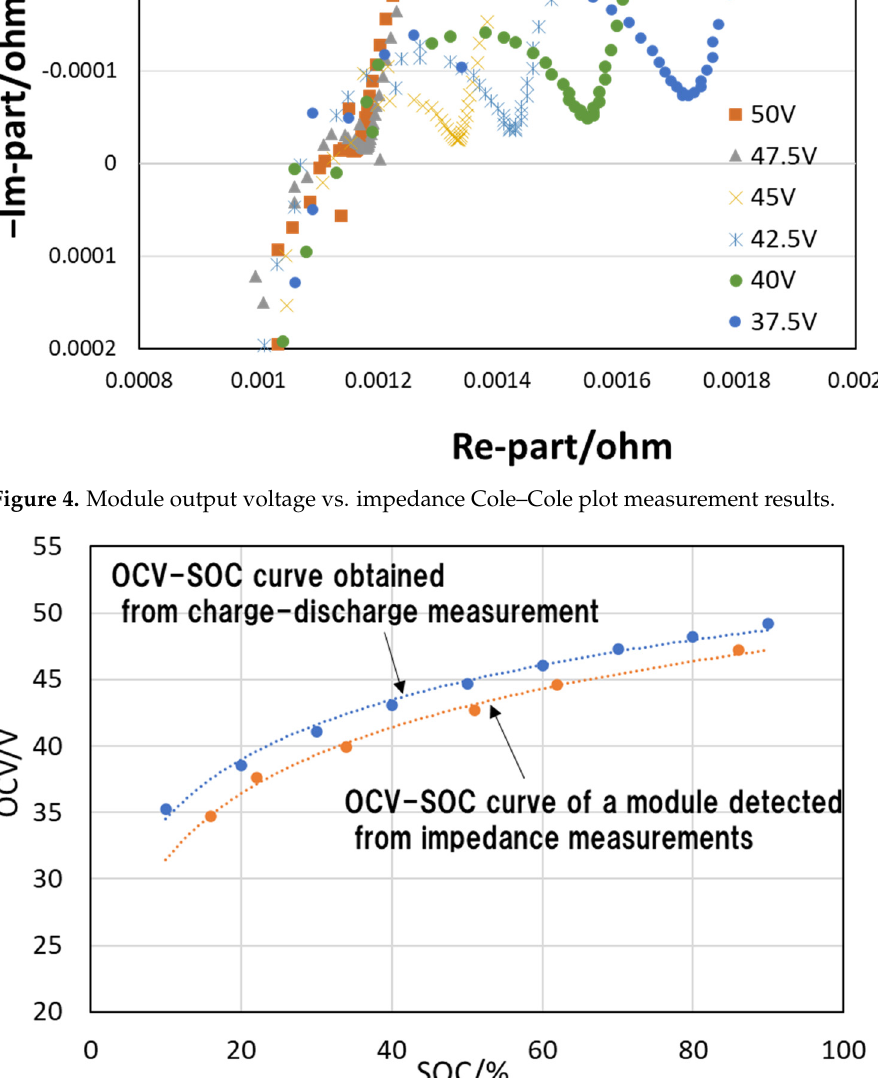
Figure 5. OCV–SOC plots. Dotted line represents the asymptote of the data points.